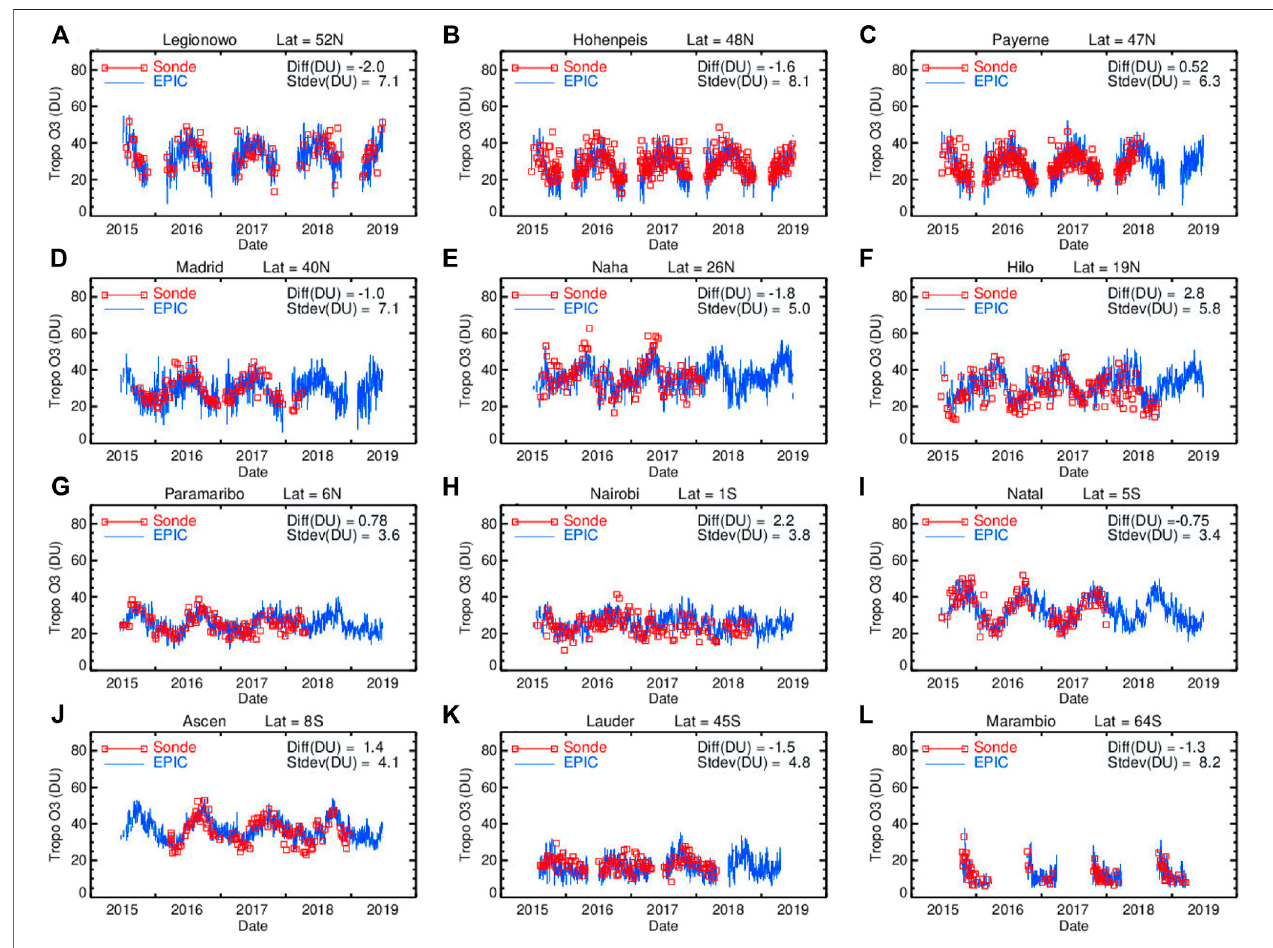
FIGURE 11 | Time series of EPIC (blue lines) and sonde (red squares) daily TCO in 2015 – 2019 at 12 ground-based locations: (A) Leginowo, Poland; (B) Hohenpeissenberg, Germany; (C) Payerne, Switzerland; (D) Madrid, Spain; (E) Naha, Japan; (F) Hilo, United States; (G) Paramaribo, Suriname; (H) Nairobi, Kenya; (I) Natal, Brazil; (J) Ascension Island; (K) Lauder, New Zeland; (L) Marambio, Antarctica. Mean differences and standard deviations in DU between EPIC and coincident sonde TCO measurements are quoted in each panel.